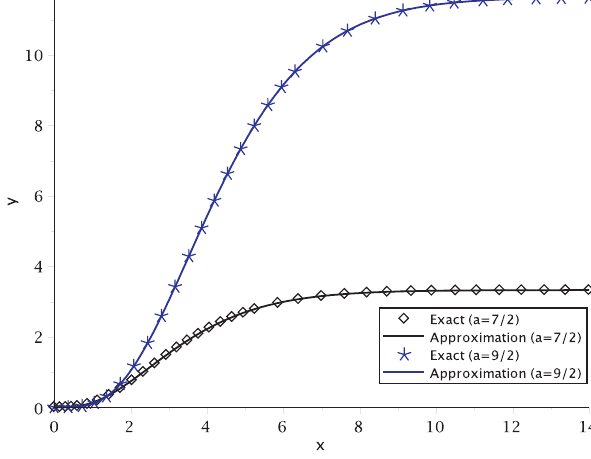
Figure 11: Exact Incomplete Gamma function versus (45) - (49)